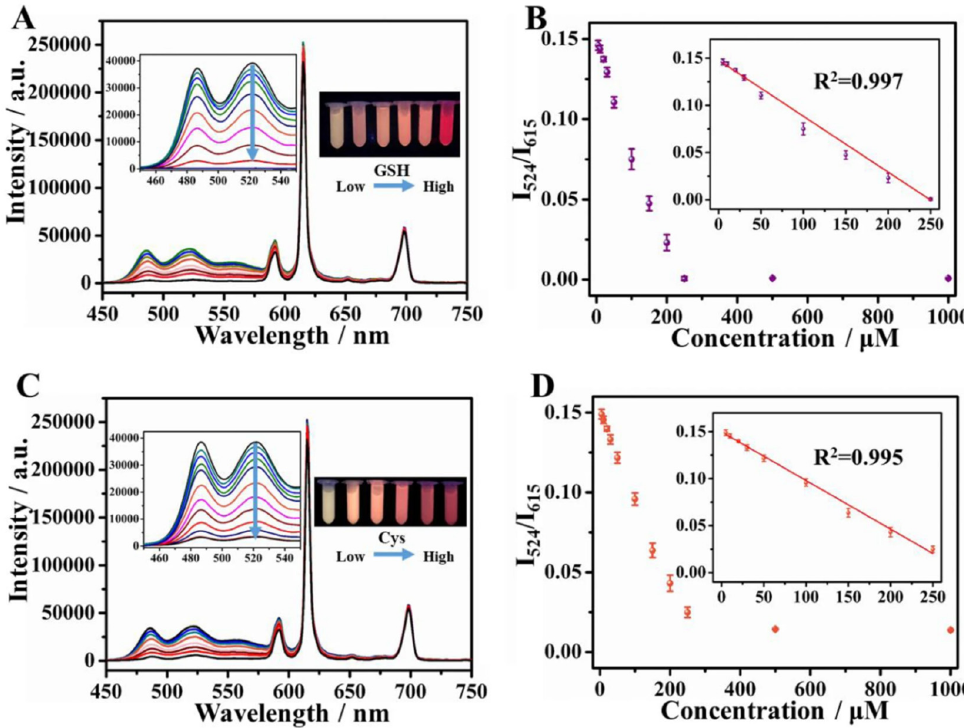
Figure 15. Ratiometric fluorescence sensing of GSH ( A , B ) and Cys ( C , D ) by Ag/Eu@Ni-MOF nanosheets. ( A , C ) represents the emission spectra of the MOFs in response to different concentrations of the analytes (GSH, Cys). Insets show the photos of the MOF in the solutions under UV irradiation (254 nm). ( B , D ) indicates the corresponding calibration curves obtained (I 524 /I 615 vs. concentration of analyte) with the linear fits given in the insets. Reprinted by permission from [Springer Nature Customer Service GmbH]: [Springer Nature] [Nature Materials] [Metal-organic framework nanosheets in polymer composite materials for gas separation, Yun Shu, Tao Dai, Qiuyu Ye, Dangqin Jin, Qin Xu, Xiaoya Hu], [The Author(s), under exclusive license to Springer Science+Business Media, LLC, part of Springer Nature 2021] (2021) [122].